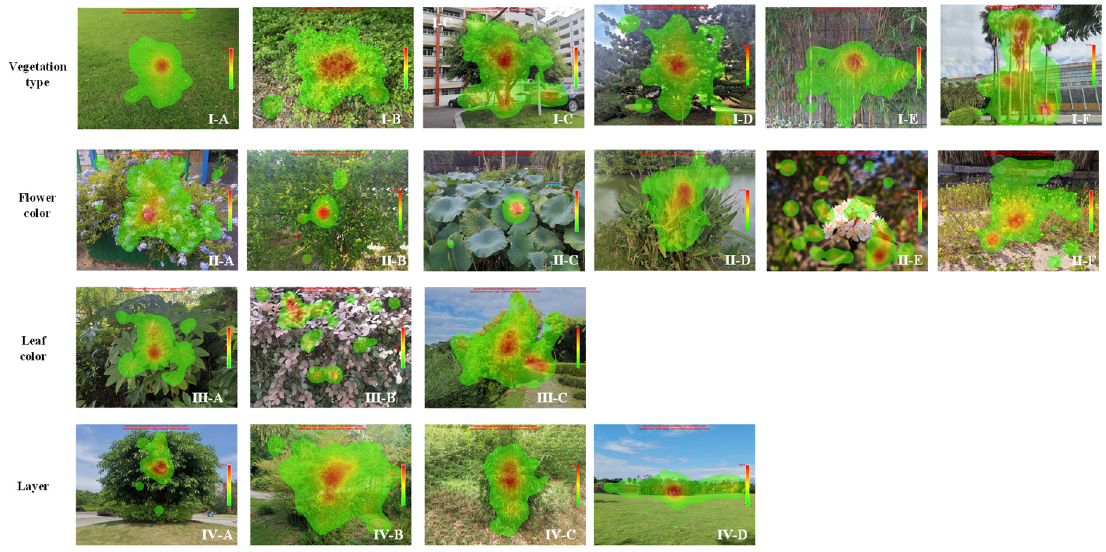
Figure 1. A heatmap of four categories associated with different visual attributes showing the position and duration of fixation. The red areas had the longest fixation time and were visually more attractive, while the green areas had the shortest fixation time and were visually less attractive.